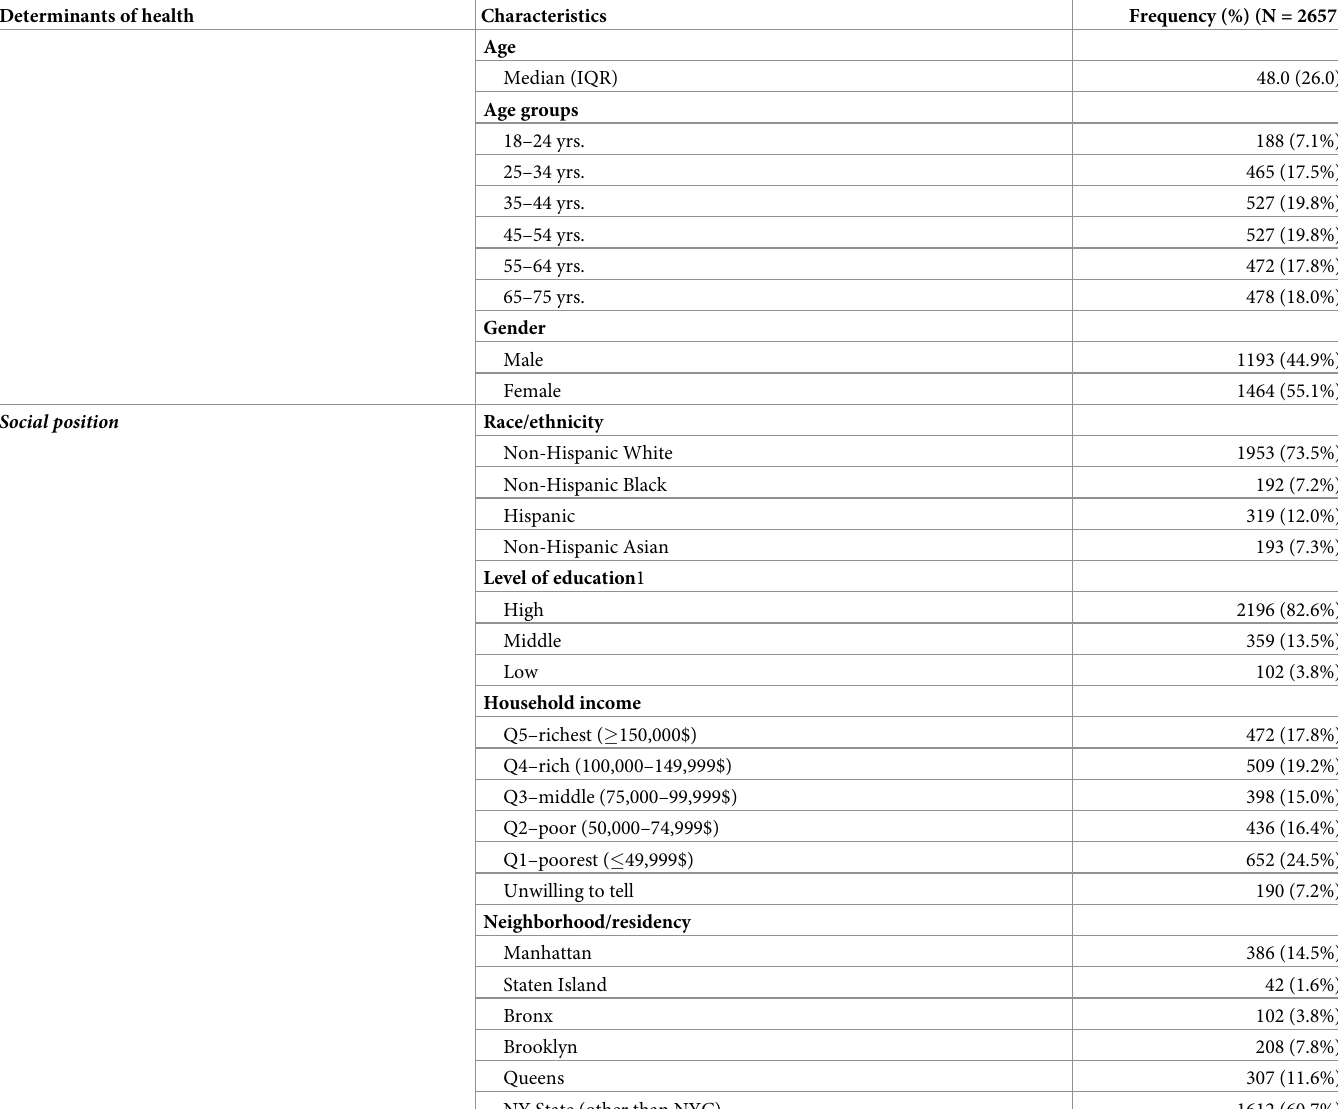
Table 1. Characteristics of